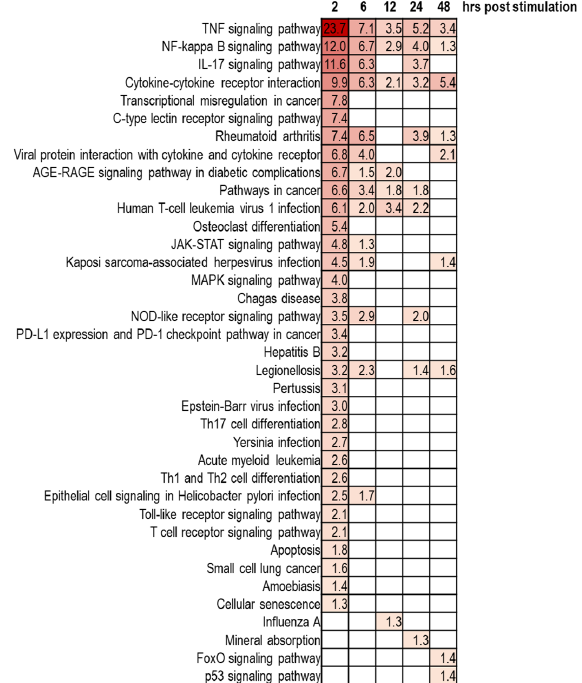
Figure 4. KEGG pathway enrichment analysis of upregulated genes by Fusobacterium nucleatum infection in human gingival fibroblasts. Gingival fibroblasts were infected with Fusobacterium nucleatum for 2, 6, 12, 24, and 48 h, and KEGG pathway analysis was performed. The color indicates the degree of statistical significance, and negative log10 of adjusted p values were presented in each box. Data were extracted and analyzed from the NCBI GEO profile database (GEO accession: GSE118691) [111]. Determination of upregulated genes at each time point was based on fold-change of the expression level > 2 and a p -value < 0.05.